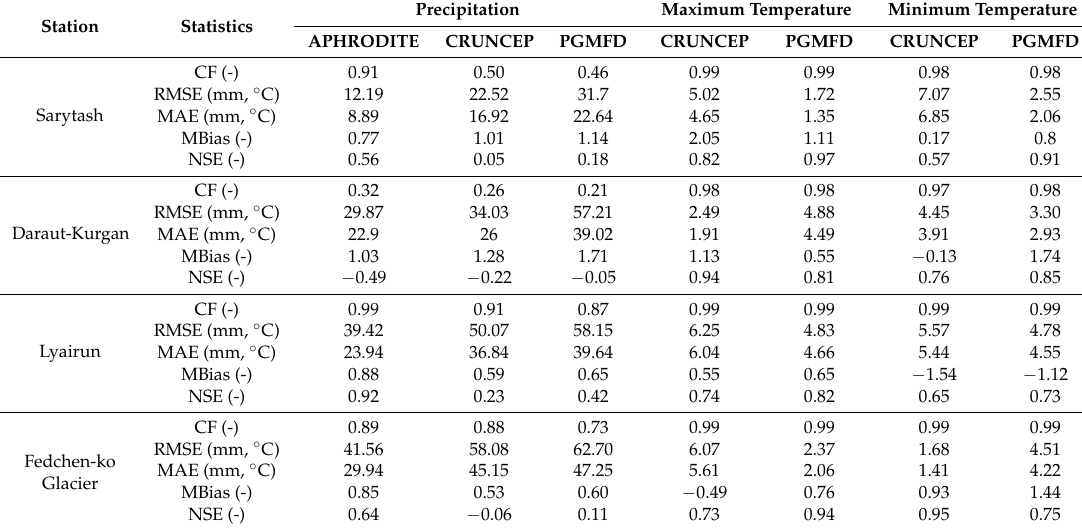
Table 2. Comparative statistics of precipitation and temperature data from different sources at four stations.